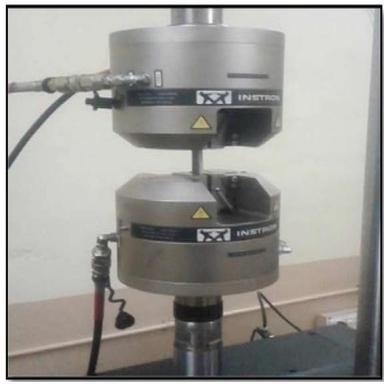
Fatigue testing of 31% sample.